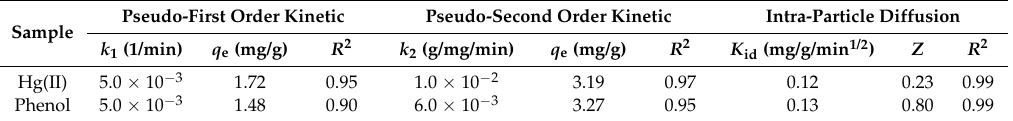
Table 1. Rate constants ( k 1 and k 2 ), sorption capacity ( q e ), and R 2 values obtained from the pseudo-first order and pseudo-second order kinetic models, along with the intra-particle diffusion constants obtained for the adsorption of Hg(II) and phenol by functionalized-AC.